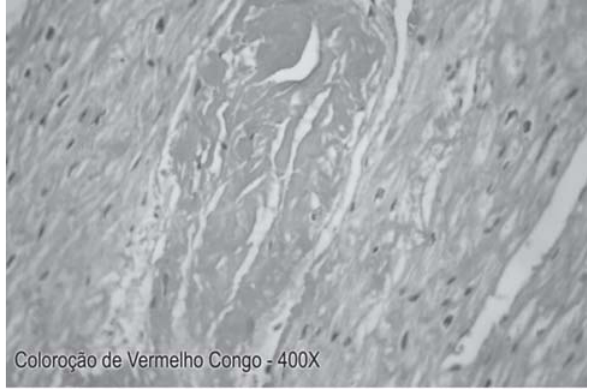
Fig. 3 - Biópsia endomiocárdica demonstrando amiloidose